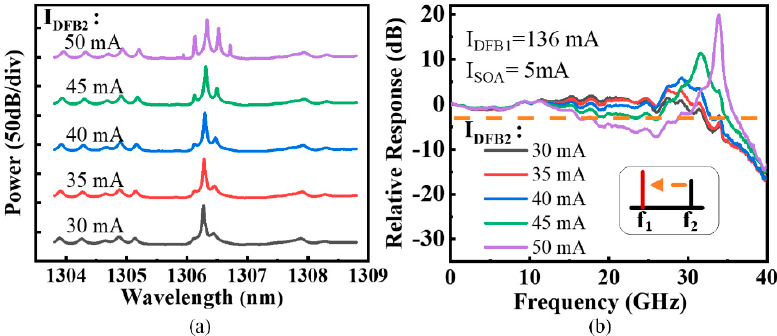
Figure 7. ( a ) Lasing spectra and ( b ) corresponding small-signal modulation response of the IMC laser with different I DFB2 values. Here, I DFB1 and I SOA were fixed at 136 and 5 mA, respectively. Inset: schematic diagram of the detuning frequency’s variation as I DFB2 varied.